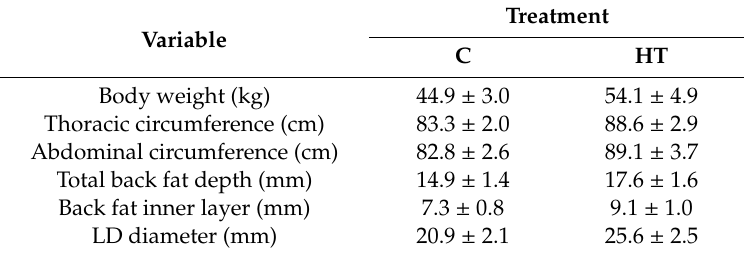
Table 1. Mean values ( ± S.E.M.) of body weight, thoracic and abdominal circumferences, thickness of both total subcutaneous back fat and its inner layer, and diameter of longissimus dorsi (LD) in 180 days-old pigs born from sows treated or not with hydroxytyrosol (groups HT and C, respectively). All values are significantly di ff erent between treatments ( p < 0.05 for all).